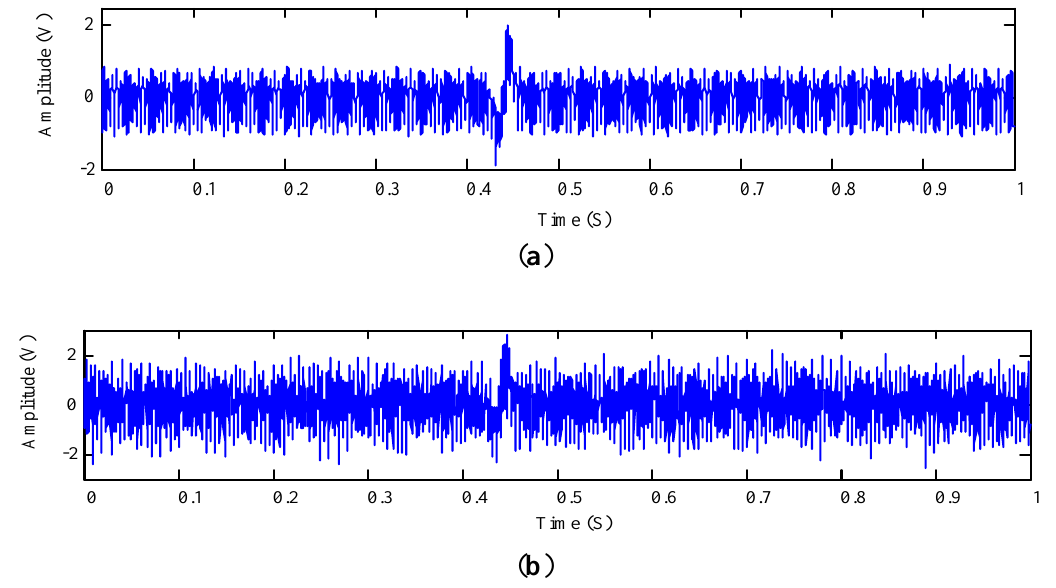
Figure 11. Particle signature of the 508 μm aluminum particle: ( a ) sensor output signal r ( t ); and ( b ) mixed signal x ( t ) consisting of r 1